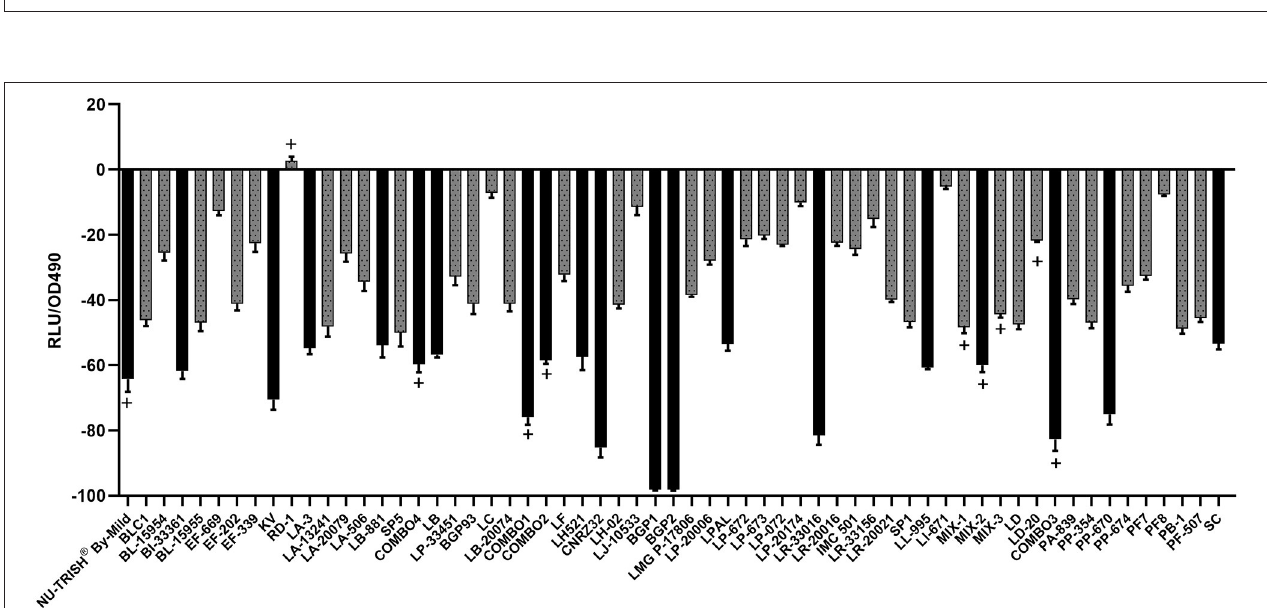
FIGURE 2 | Change in bioluminescence (%VA) of S . Typhimurium LT2 hilA :: luxCDABE after 12h incubation in nCFSM from 61 different LAB strain cultures. Strains where growth in the nCFSM resulted in more than 50 % reduction in bioluminescence compared to growth in unfermented milk are shown as black bars. The hilA measurement was based on one biological replicate of nCFSM with technical triplicates. The multi-strain starter cultures are marked with ( + ).